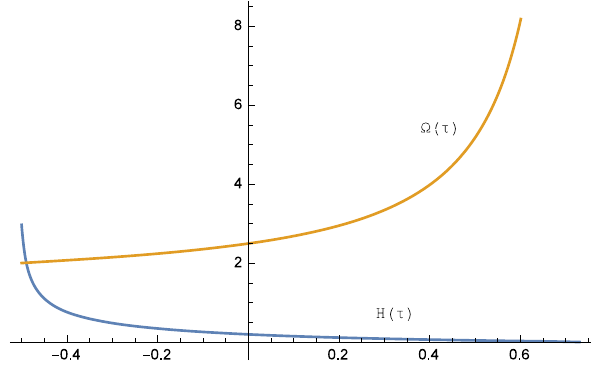
Fig. 10 Numerical solution for γ = 1 / 2, λ = 2 and (cid:4) 0 > 2. (cid:4)(τ) develops a singularity at about τ ∼ 0 . 74 and H (τ) has a singularity at τ ∼ − 0 . 5